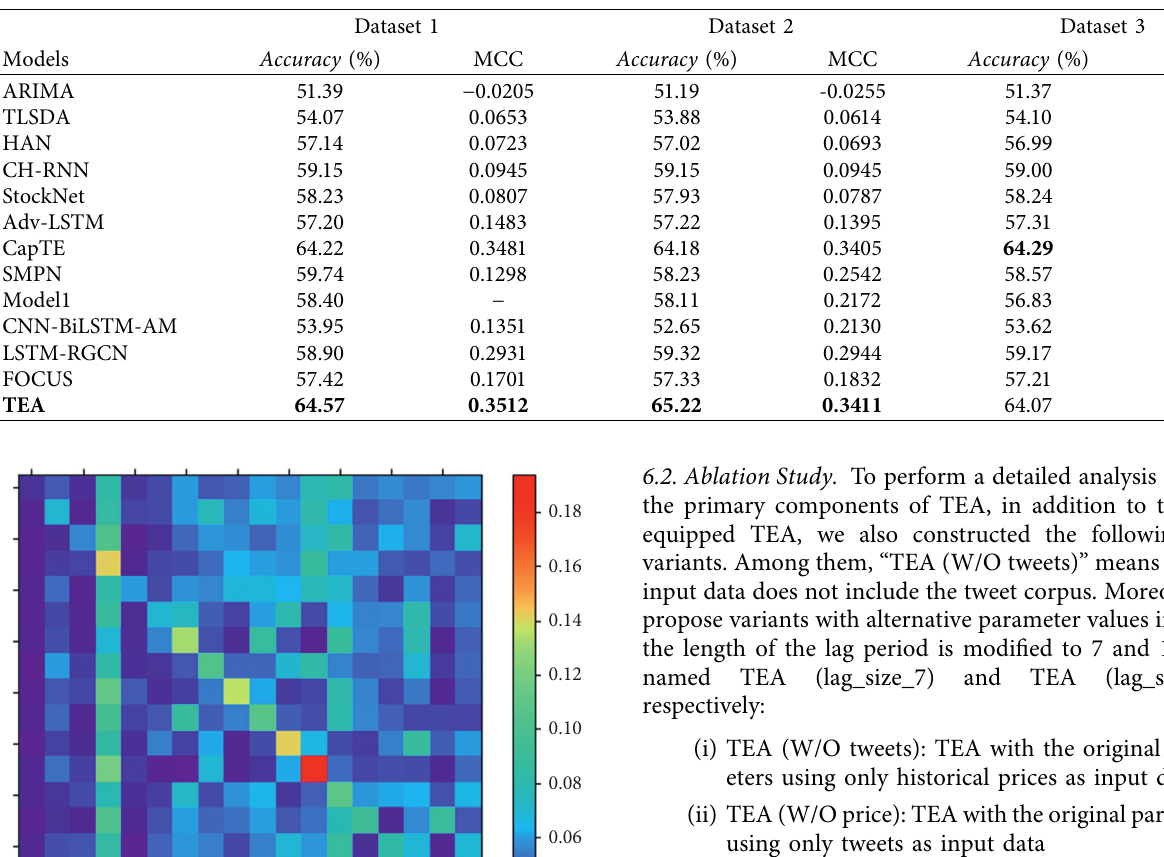
Table 1: Performance of baselines and TEA in Accuracy and MCC.